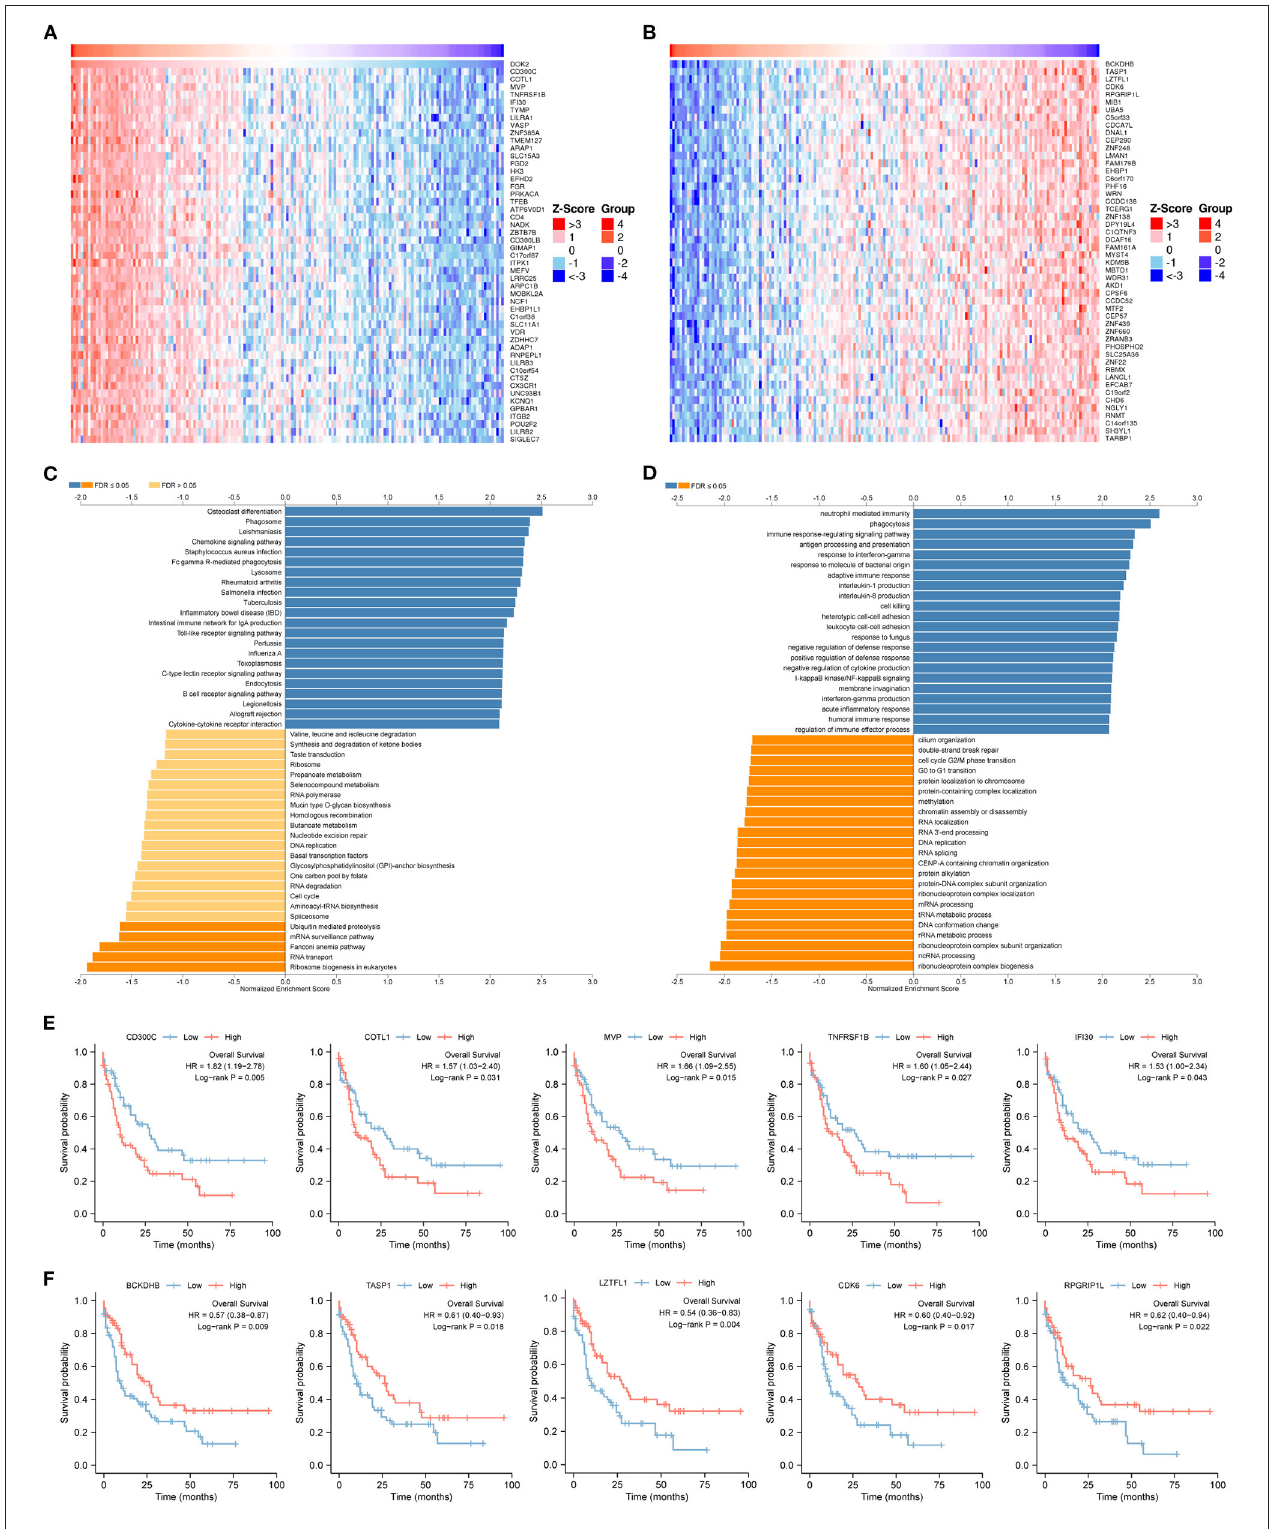
FIGURE 6 | Genes co-expressed with DOK2 according to LinkedOmics. (A) Heatmap for top 50 significant genes positively correlated with DOK2 in AML. (B) Heatmap for top 50 significant genes negatively correlated with DOK2 in AML. (C) GSEA analysis of GO_BP terms analyzed using LinkedOmics. (D) GSEA analysis of KEGG terms analyzed using LinkedOmics. (E) Prognostic value of top 5 ranked genes positively correlated with DOK2 in the TCGA AML. (F) Prognostic value of top 5 ranked genes negatively correlated with DOK2 in the TCGA AML.